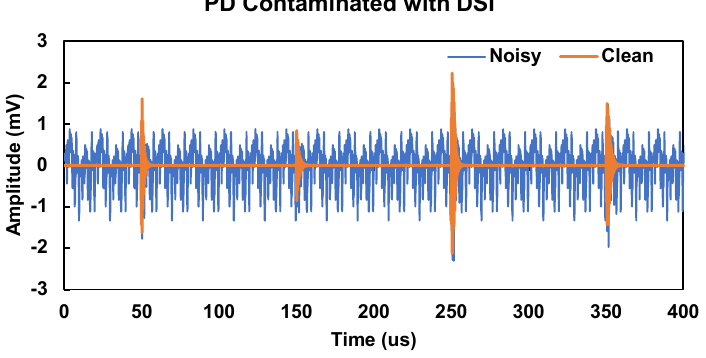
Figure 11. Simulated partial discharge signal contaminated with discrete spectral interference. Signal SNR = 0.35 dB and NCC = 0.28.